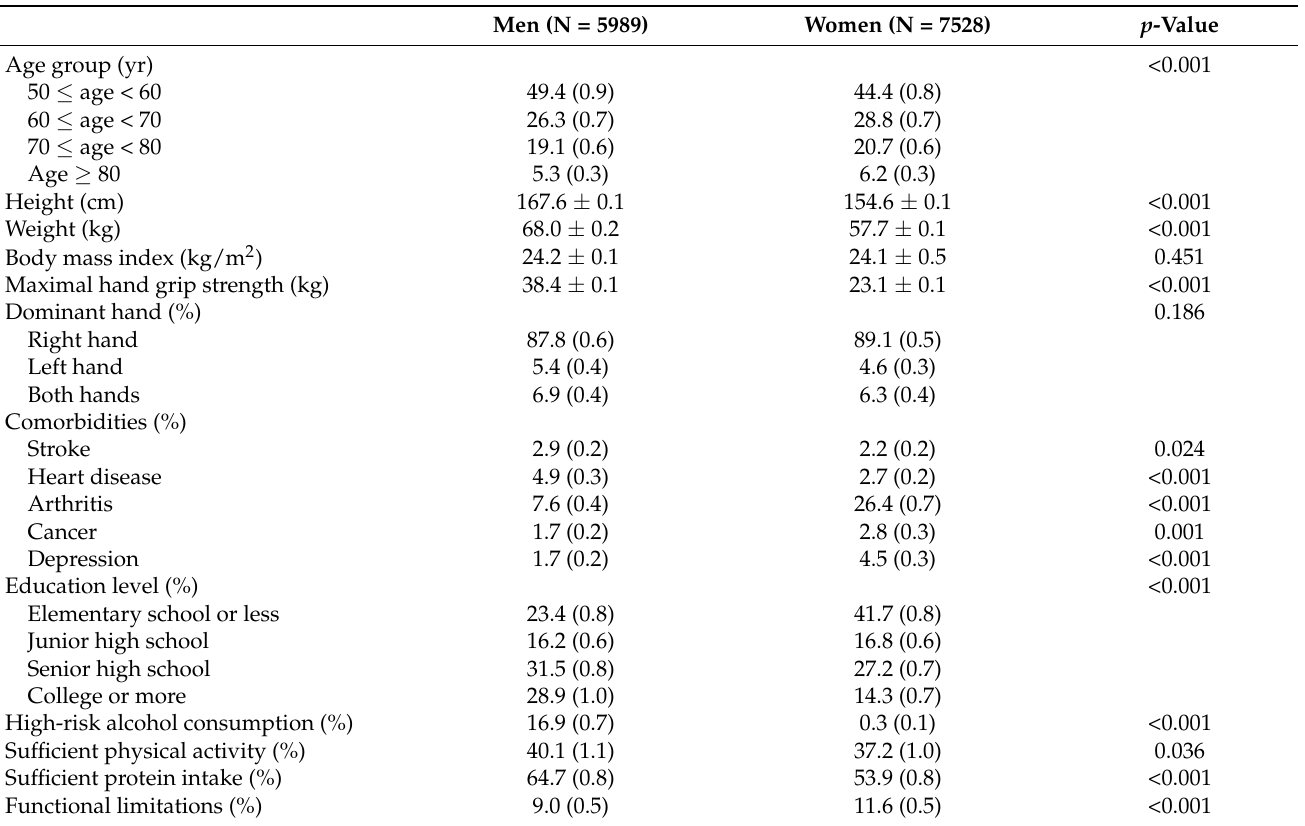
Table 1. Baseline characteristics of the study participants (N =